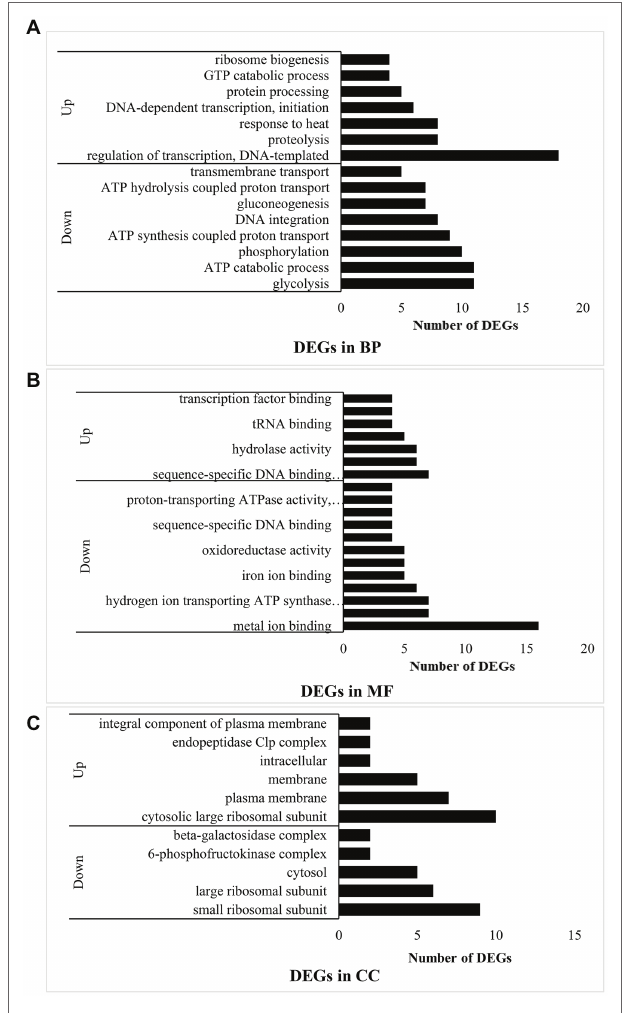
FIGURE 2 | Function analysis of DEGs in B vs. A. (A) means DEGs in biological process (BP); (B) means DEGs in molecular function (MF); and (C) means DEGs in cellular component